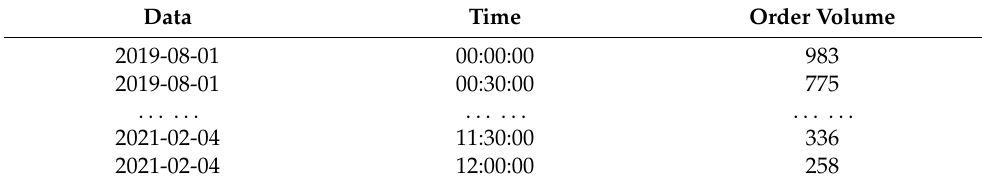
Table 1. Raw Data.